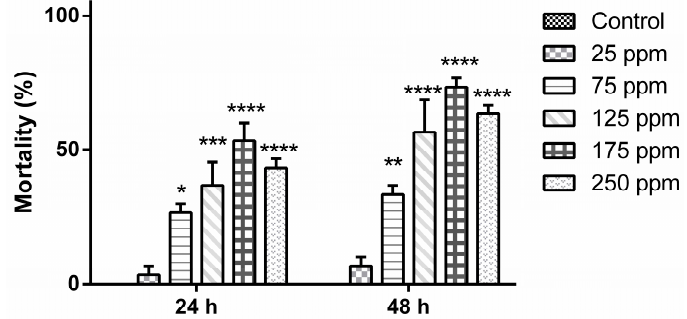
Figure 1. Mortality levels (%) of Aedes aegypti (early fourth-instar larvae) after treatment with Baccharis reticularia essential oil-based nanoemulsion. Significance: * p < 0.05; ** p < 0.01; *** p < 0.001; **** p < 0.0001.